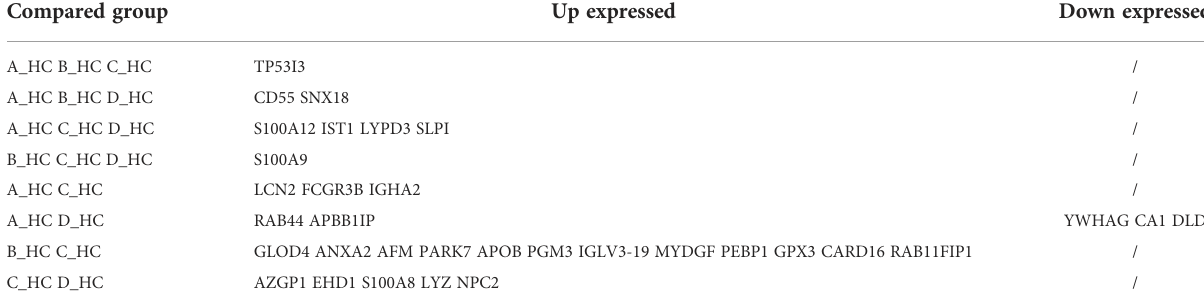
TABLE 4 The overlapped DEPs in the comparison between IgG4-RD with four subgroups and HC. Compared group